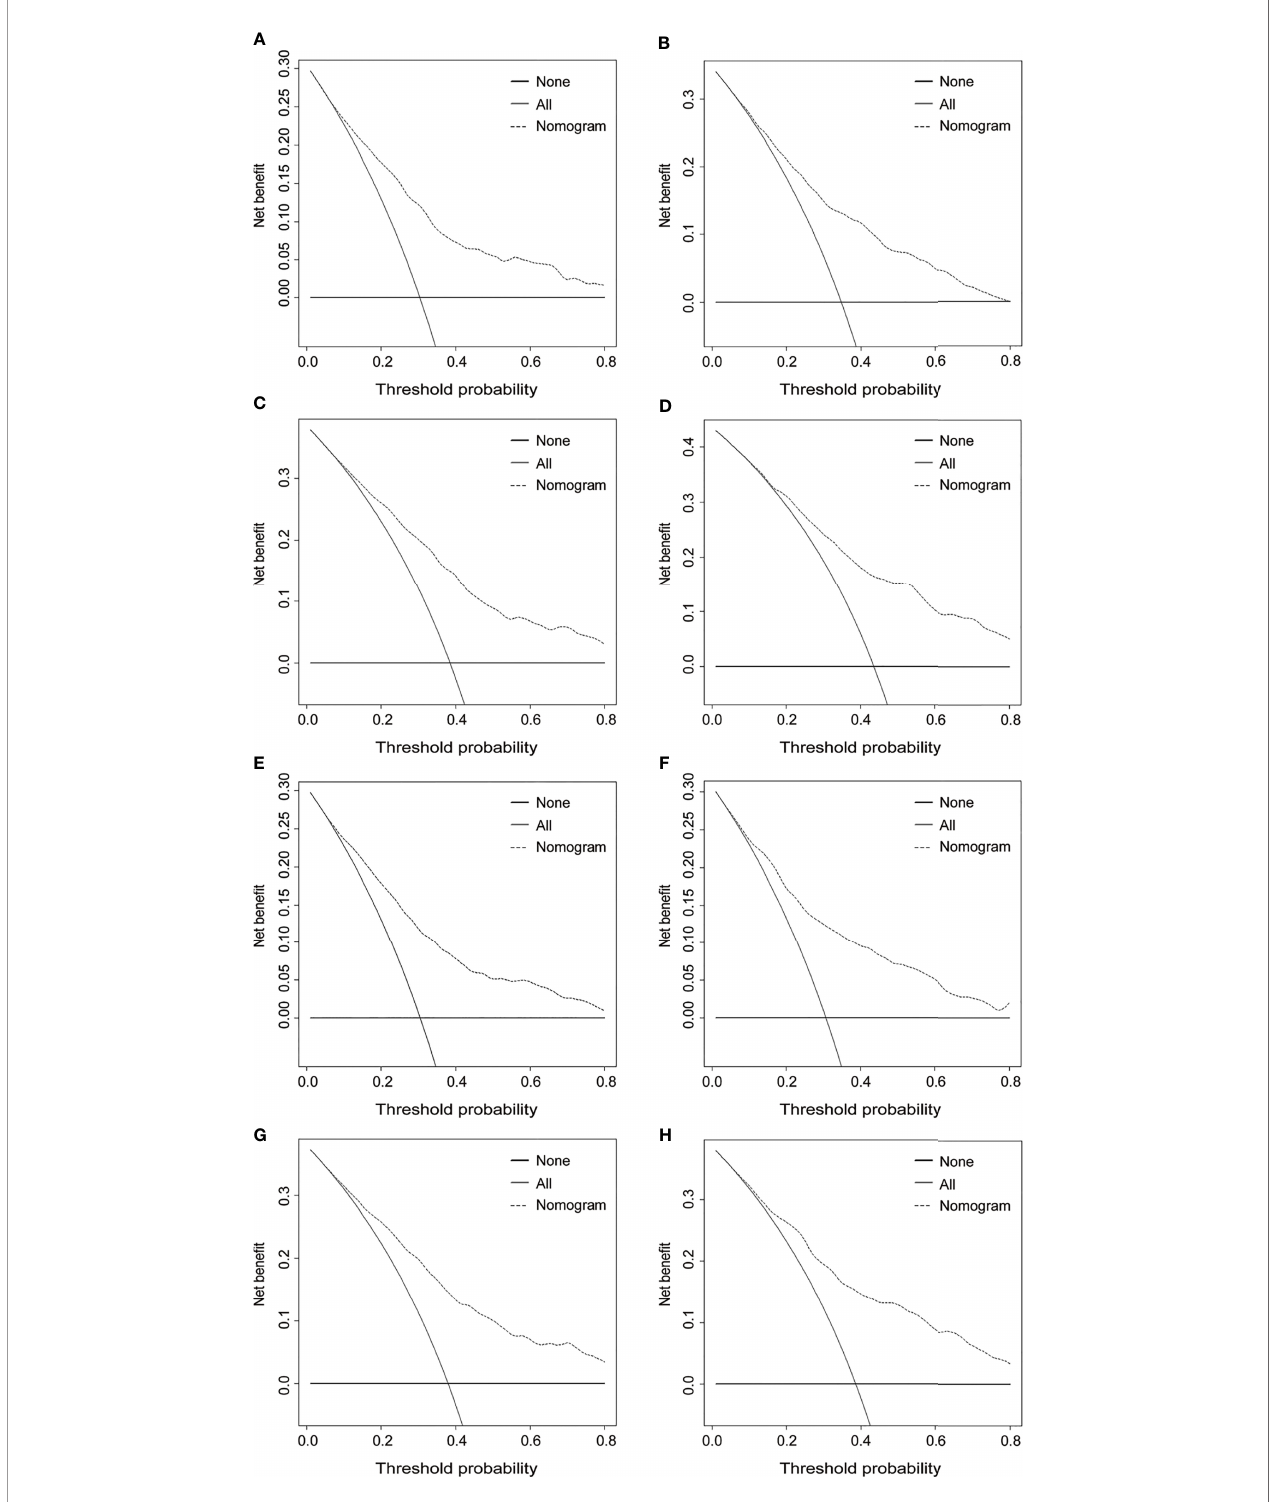
FIGURE 6 | Decision curve analysis for 3- and 5-year OS and CSS of the prognostic nomograms. Decision curves for 3- and 5-year OS in the training cohort (A, C) and the validation cohort (B, D) . Decision curves for 3- and 5-year CSS in the training cohort (E, G) and the validation cohort (F, H) . OS, overall survival; CSS, cancer-speci fi c